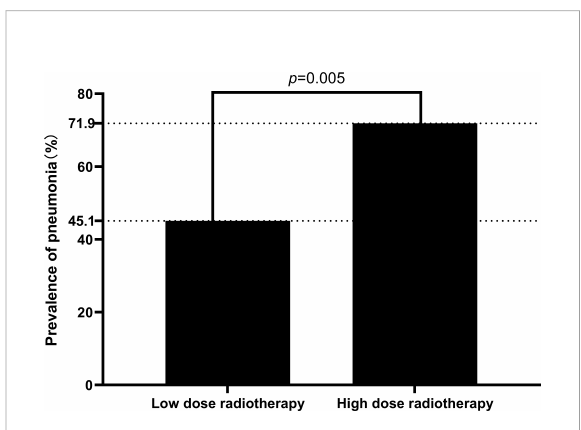
FIGURE 2 Differences in the prevalence of pneumonia between the two